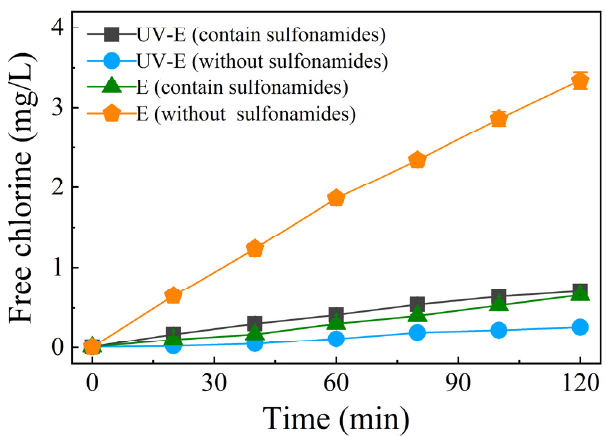
Figure 9. The free chlorine yield with different treatments (with or without sulfonamides). Conditions: Cl − concentration of 50 mg/L, no aeration, UV power of 48 W, current of 1.8 A (4.8 mA/cm 2 ), and initial pH of 8.3.